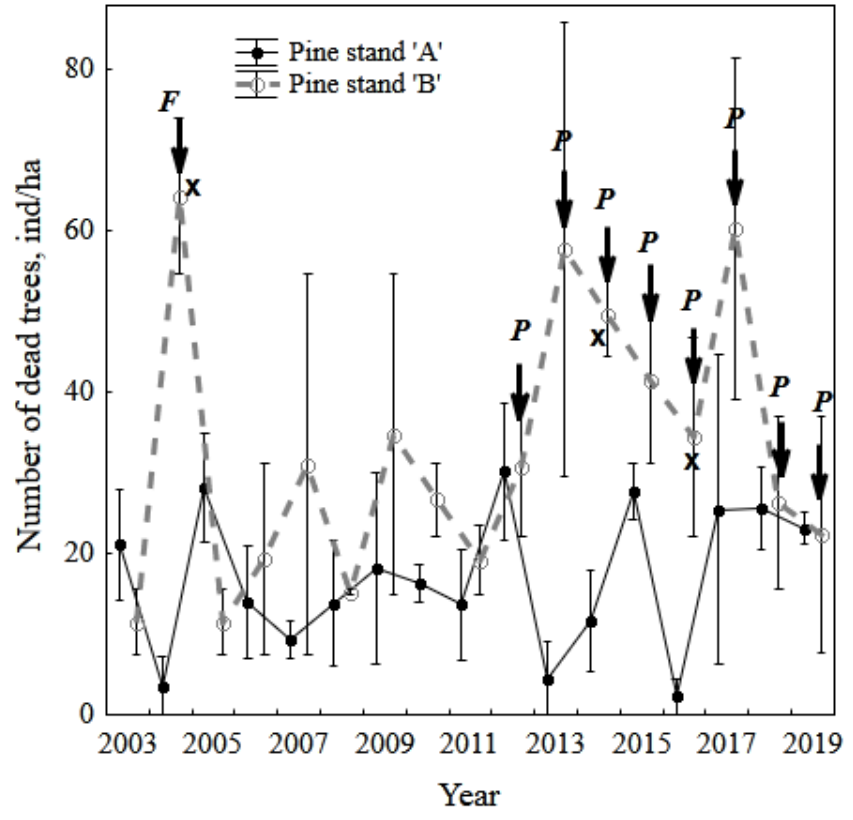
Figure 4. Number of trees which died in 2002–2019. Acute or chronic impacts on the stands were caused by the thermal factor ( F , a creeping fire) or chemical factor ( P , pollutants), respectively. “X“ marks a significant difference between pine stands ‘A’ and ‘B’ ( p < 0.05 by the t -test). Average values for 2–3 permanent sample plots and their standard errors are shown.